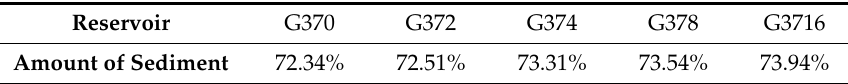
Table 4. The amount of sediment entrapped for different G/D.